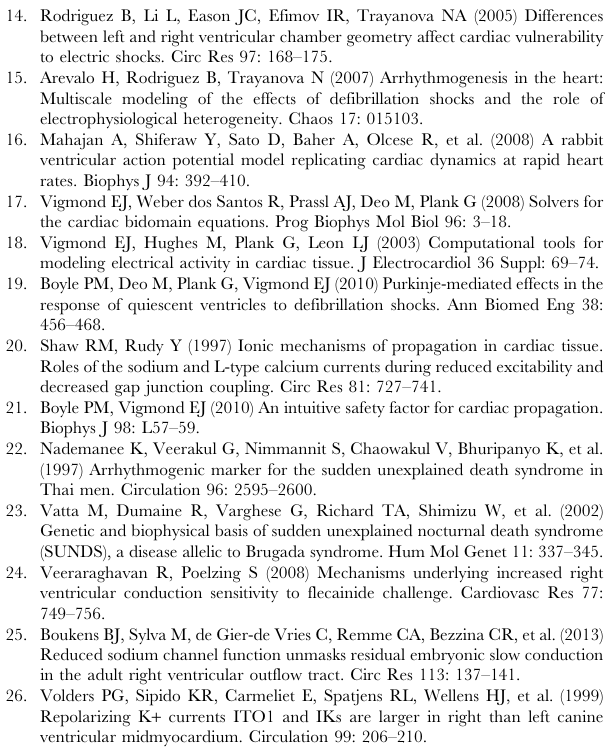
Q thr is the threshold charge to elicit an action potential in an uncoupled cell; t A is the excitation interval (stimulus duration); and CI is coupling interval. Table S1: Convergence analysis conducted in a tissue wedge (5 cm 6 1 mm 6 1 mm) with the same electrophysiological properties as described in the Materials and Methods section. Simulations conducted with 30% of normal I Na . Table S2: Additional simulation details for rabbit ventricular models. Appendix S1: Pseudo-code for calculating safety factor according to the method described in this paper. (PDF) Movie S1 Anterior epicardial (left) and basal (right) views of sustained arrhythmia initiation by a PVC originating from site E1 in a simulation with 30% of normal I Na and arrested sinus rhythm. Maps show transmembrane voltage (V m ) on the surface of the ventricles; same scale as Fig. 3A. (MOV) Movie S2 Posterior endocardial cutaway (left) and basal cutaway (right) views of sustained arrhythmia